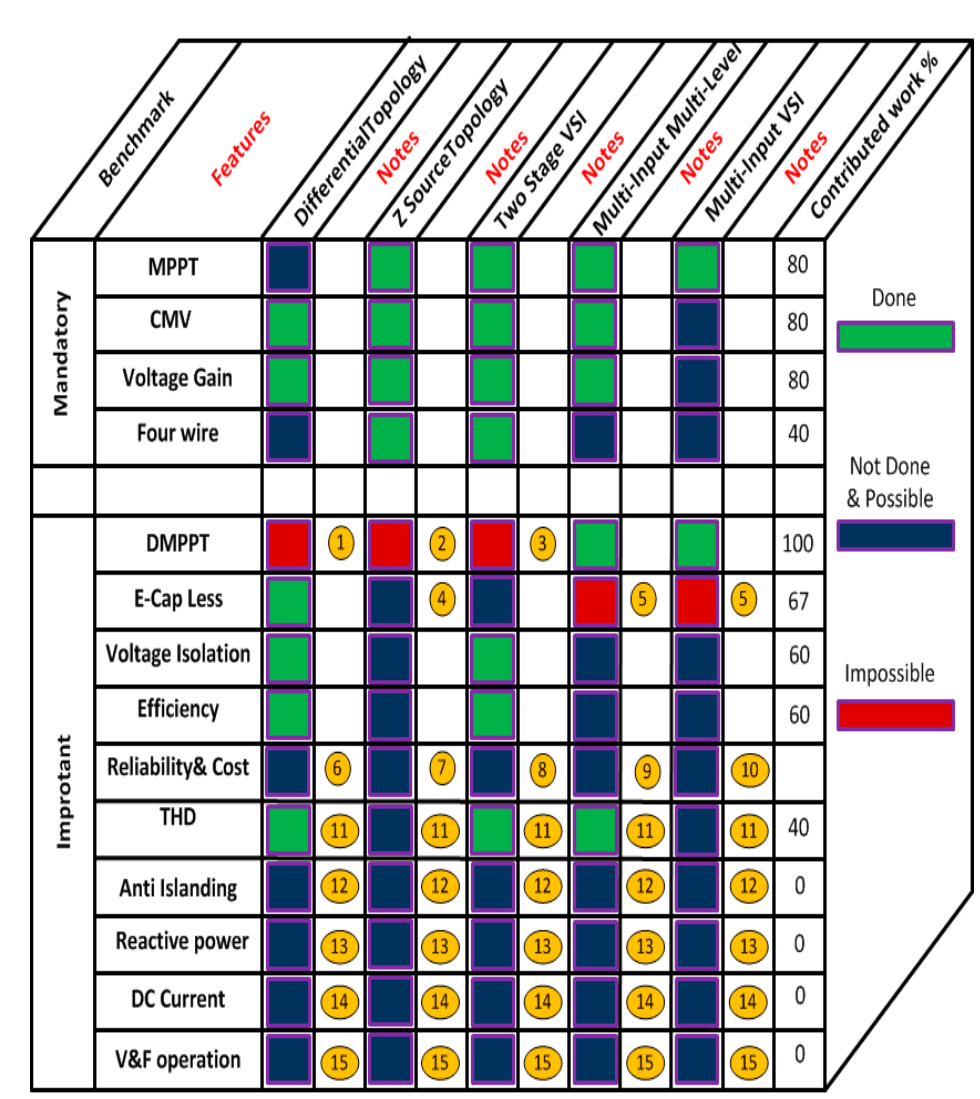
Figure 25. Evaluation of all discussed topologies based on the developed marking system.